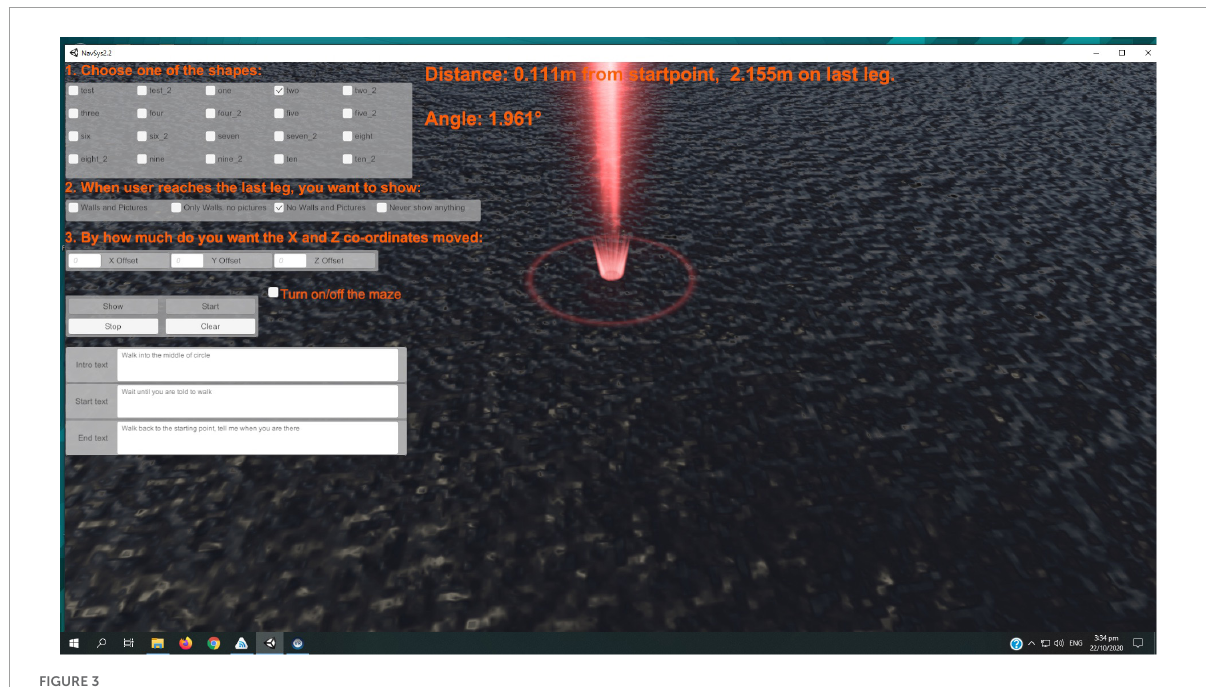
FIGURE3 Image of the virtual environment.